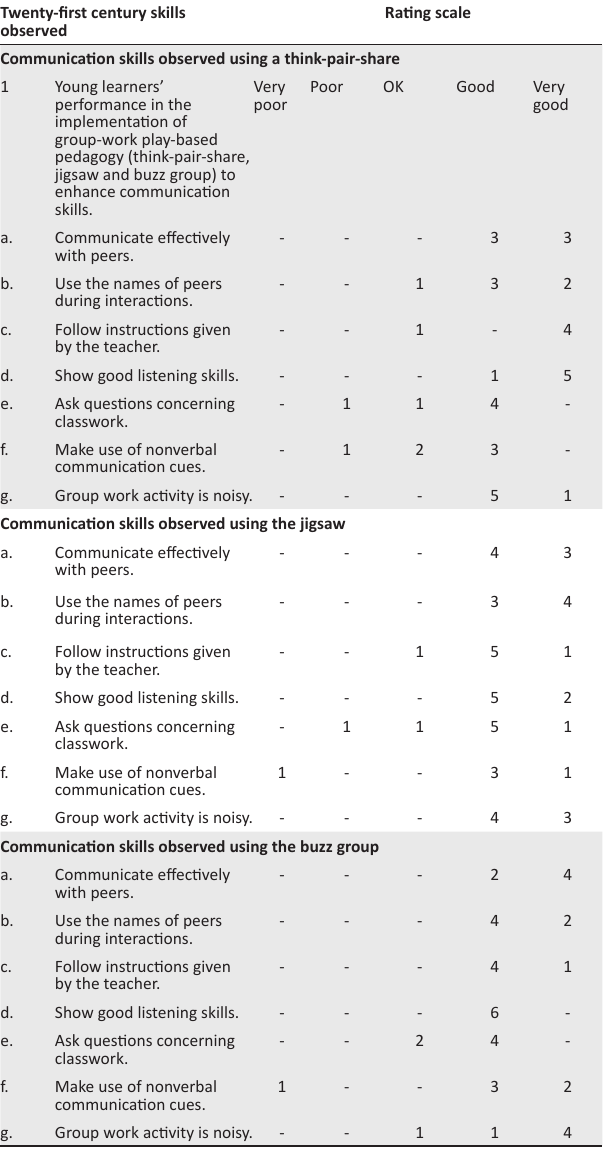
TABLE 2: Observation schedule for think-pair-share, jigsaw and buzz group. Twenty-first century skills